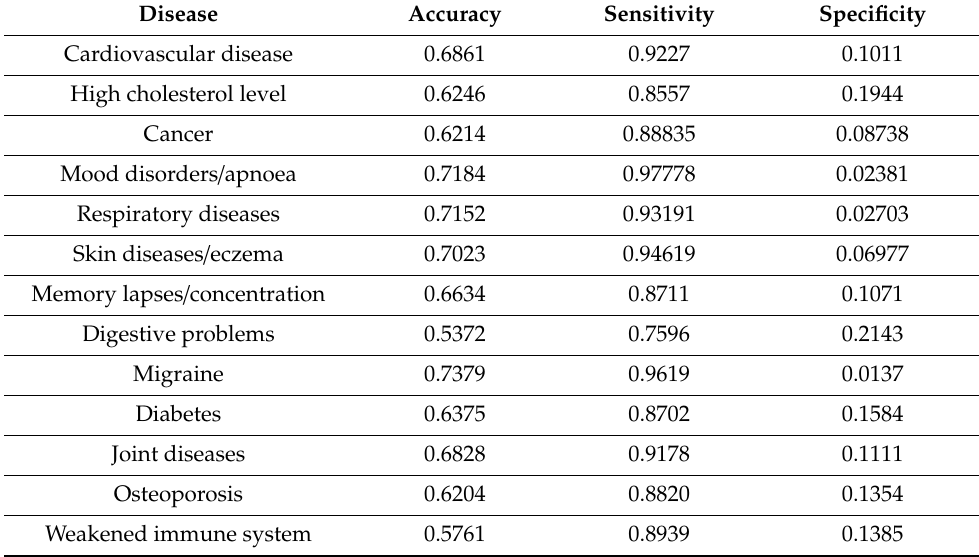
Table A3. Accuracy, sensitivity, and specificity of random forest